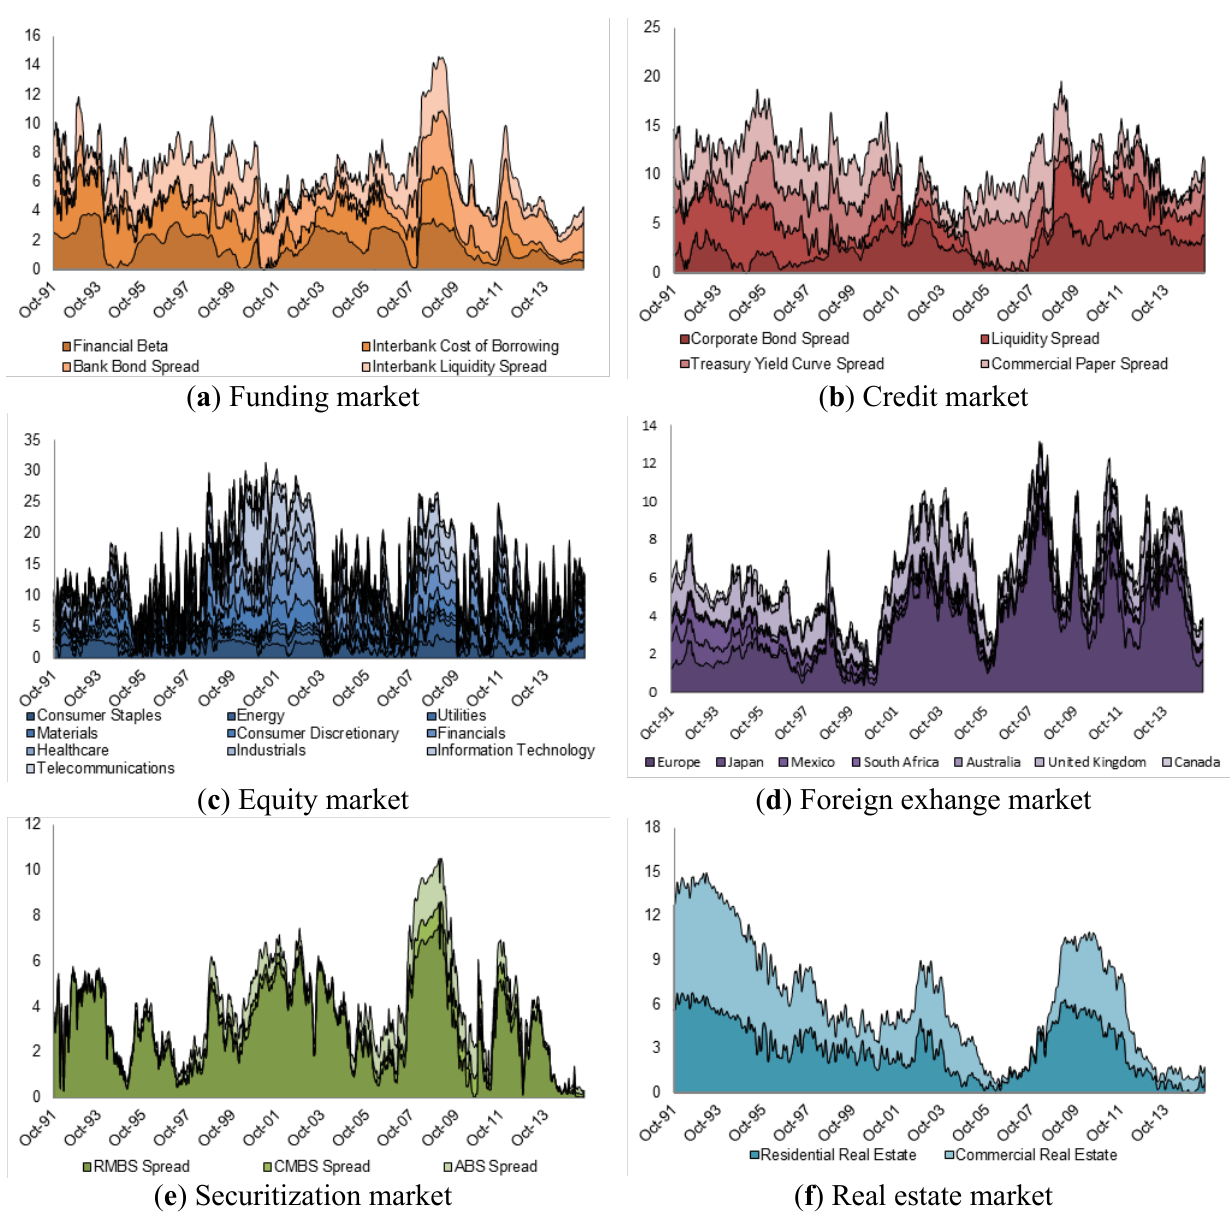
Figure 6. Decomposition of stress: Components of the funding ( a ), credit ( b ), equity ( c ), foreign exchange ( d ), securitization ( e ), and real estate ( f )